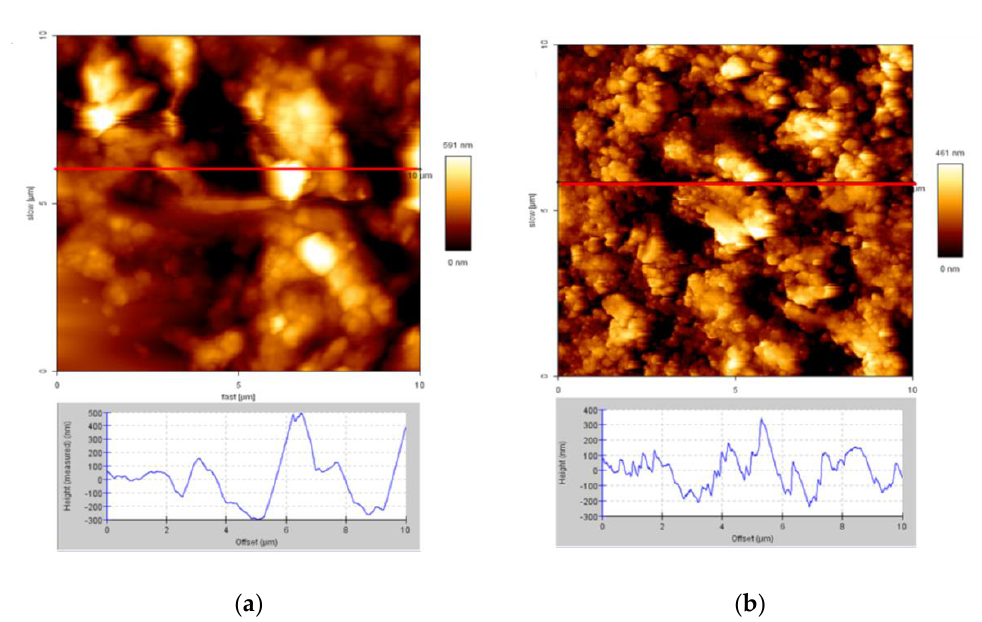
Figure 7. Atomic force microscopy (AFM) images (10 × 10 μm 2 ) and cross-section height profiles. ( a ) As-received rubber; ( b ) treated rubber.